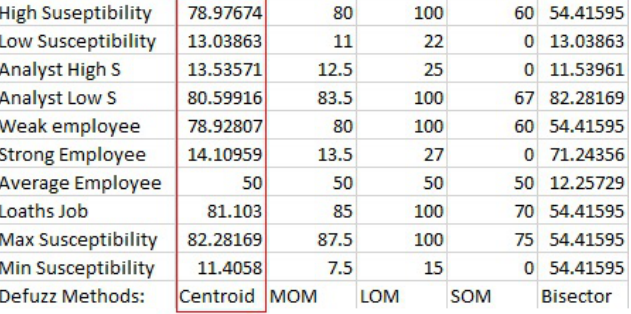
Figure 14. Defuzzification Output